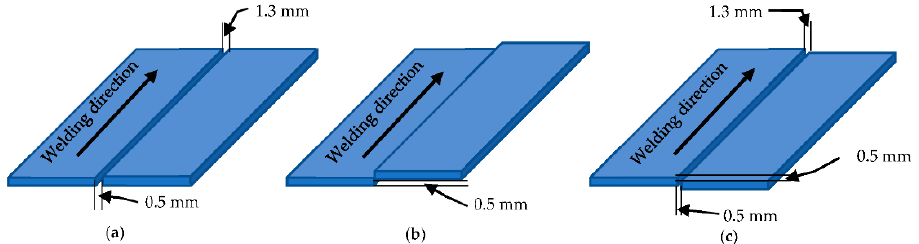
Figure 3. Workpiece joint forms. ( a ) Variable gap. ( b ) Misalignment. ( c ) Variable gap and